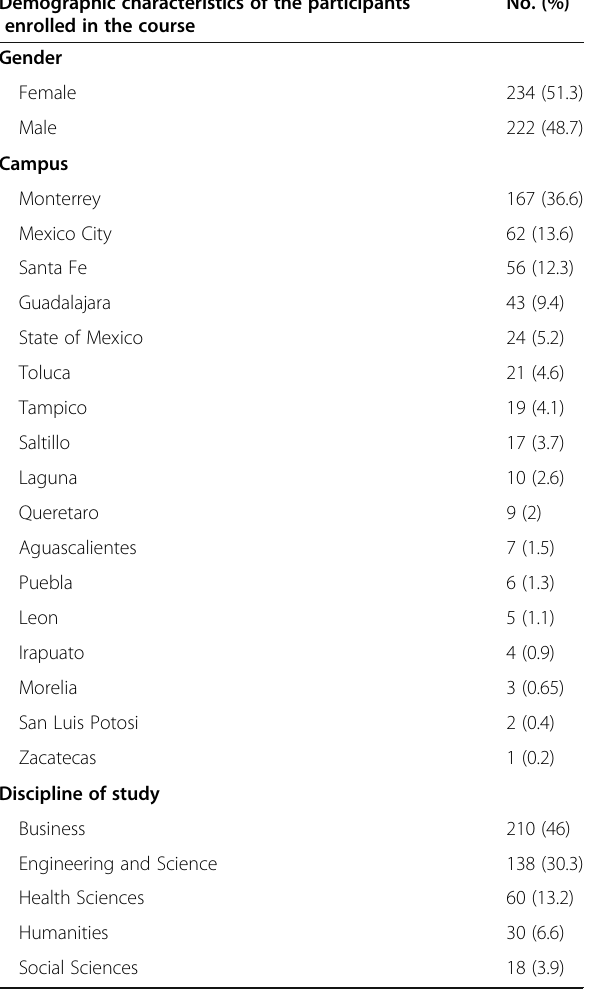
Table 1 Demographic characteristics of the study participants Demographic characteristics of the participants enrolled in the